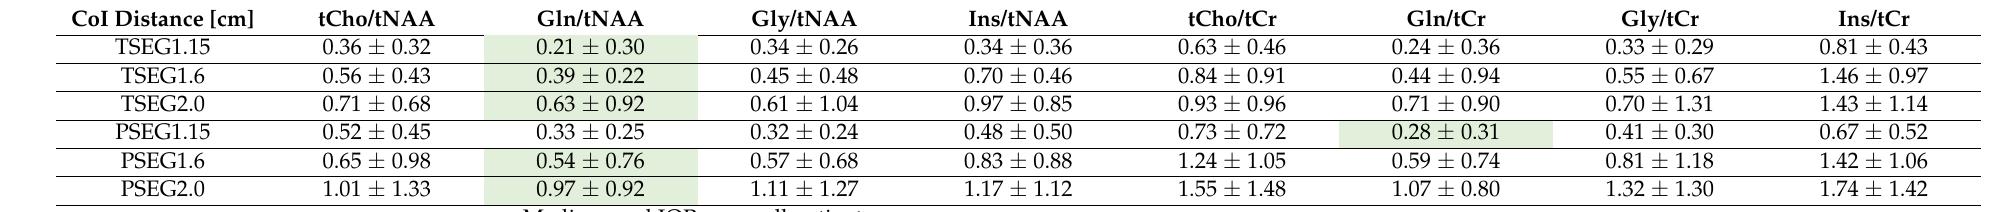
Table 4. CoI distances of MRSI to PET over all ratios and VOI